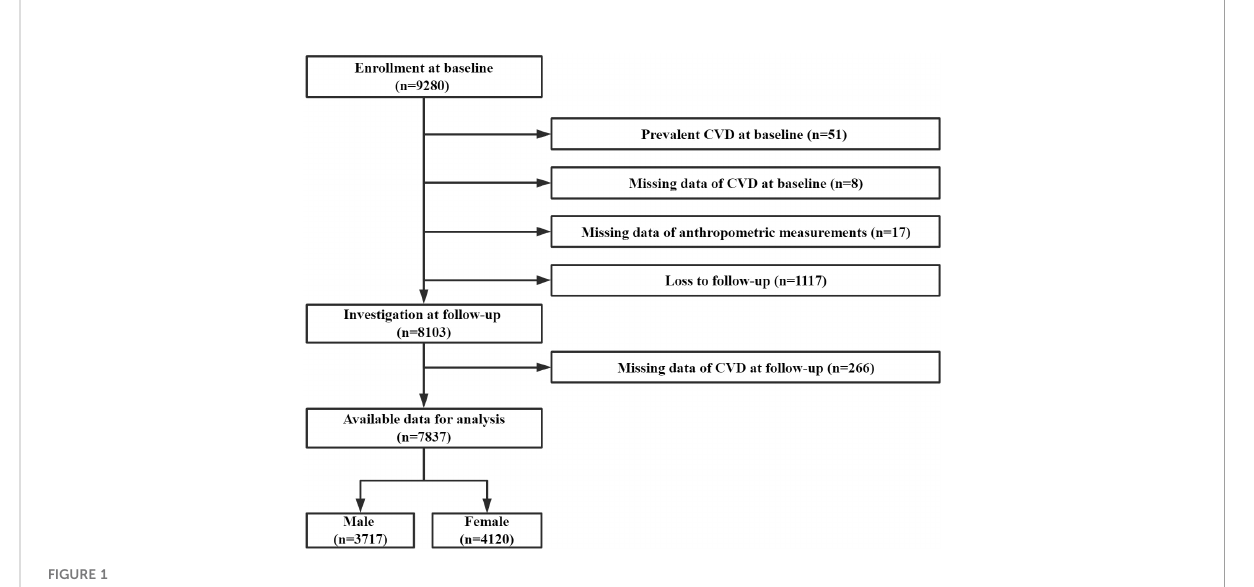
FIGURE 1 Flowchart of the